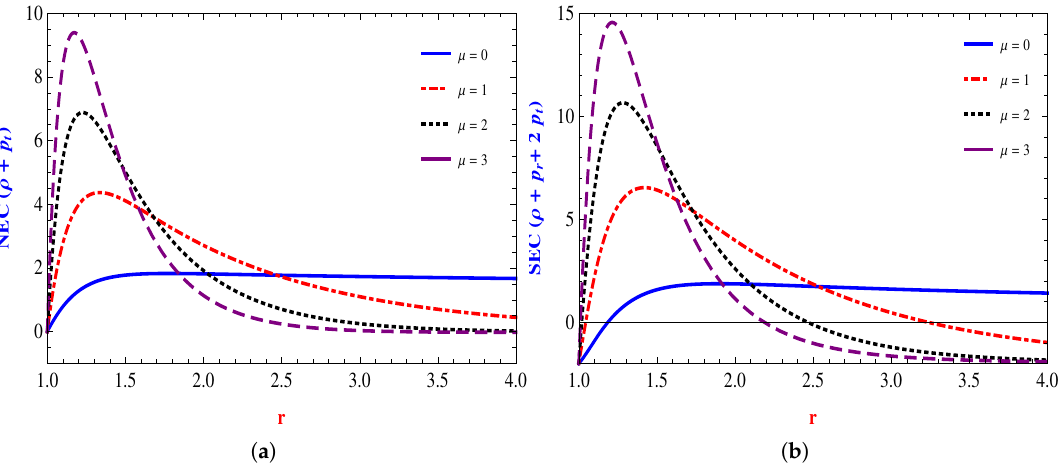
Figure 5. Plots: ( a ) Tangential NEC ( ρ + p t ) and ( b ) SEC ( ρ + p r + 2 p t ) with throat radius r 0 = 1, α = 1, and β = 2 in f ( Q ) = α Q 2 + β gravity.